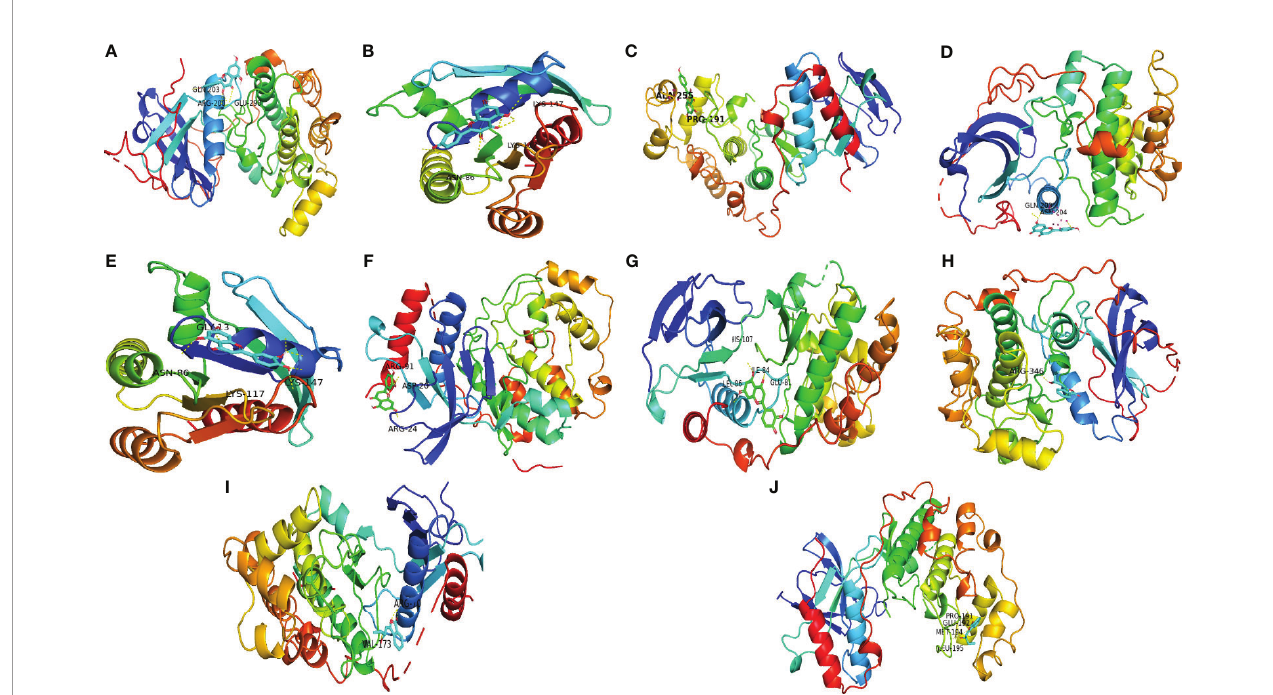
FIGURE 8 | Schematic diagram of docking results. (A) Kaempferol-AKT1; (B) Kaempferol-HRAS; (C) Kaempferol-MAPK14; (D) Luteolin-AKT1; (E) Luteolin-HRAS; (F) Luteolin-MAPK1; (G) Luteolin-MAPK14; (H) Senkyunolide E-AKT1; (I) Senkyunolide E-MAPK1; (J) Senkyunolide E-MAPK14 ARG, arginine; GLN, glutamine; LYS, lysine; GLY, glycine; ASP, aspartic acid; HIS, histidine; LEU, leucine; GLU, glutamic acid; VAL, valine; ALA, alanine; PRO, proline; ILE, isoleucine.